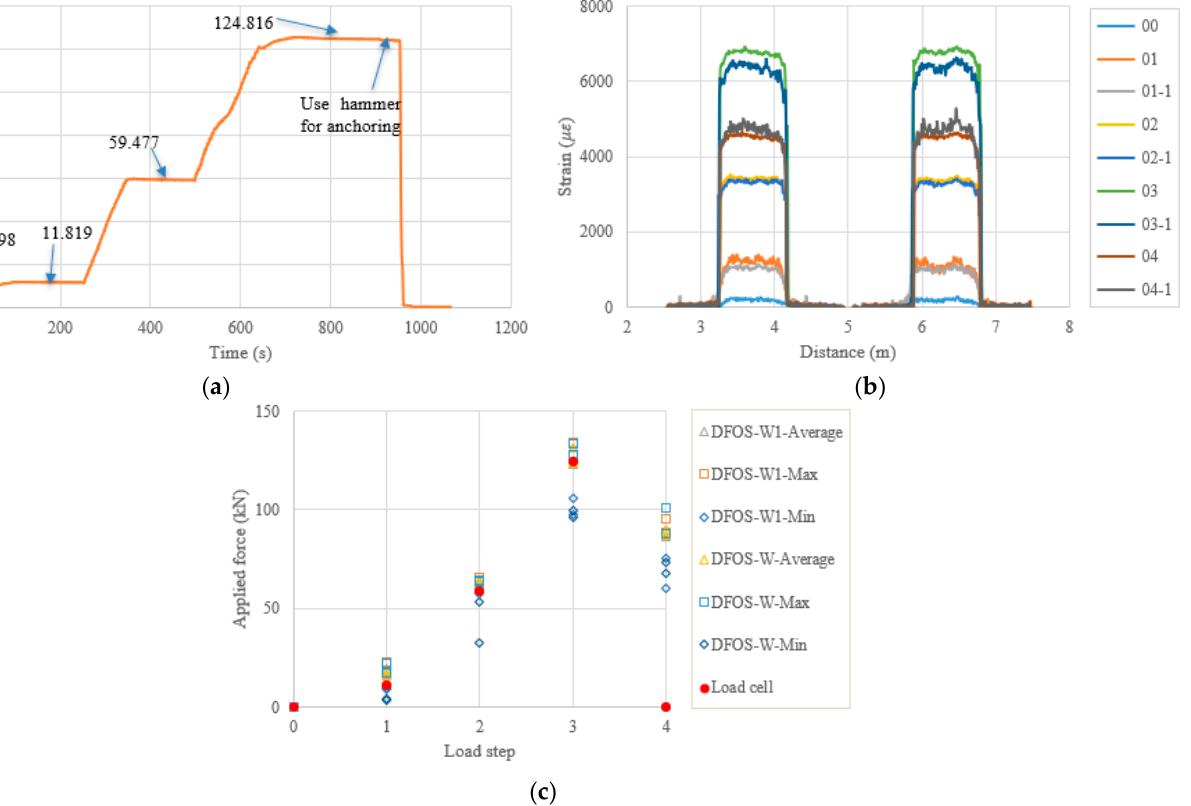
Figure 8. ( a ) Load cell readings for PC5; ( b ) strain distribution along the strand (W1 and W fibers) (In the legend, the first number represents the load step, and the second number represents measurement times at the load step.); ( c ) applied force changes at different load steps. Table 5. Prestressing force monitored by load cell and DFOS for PC5 (unit: kN).